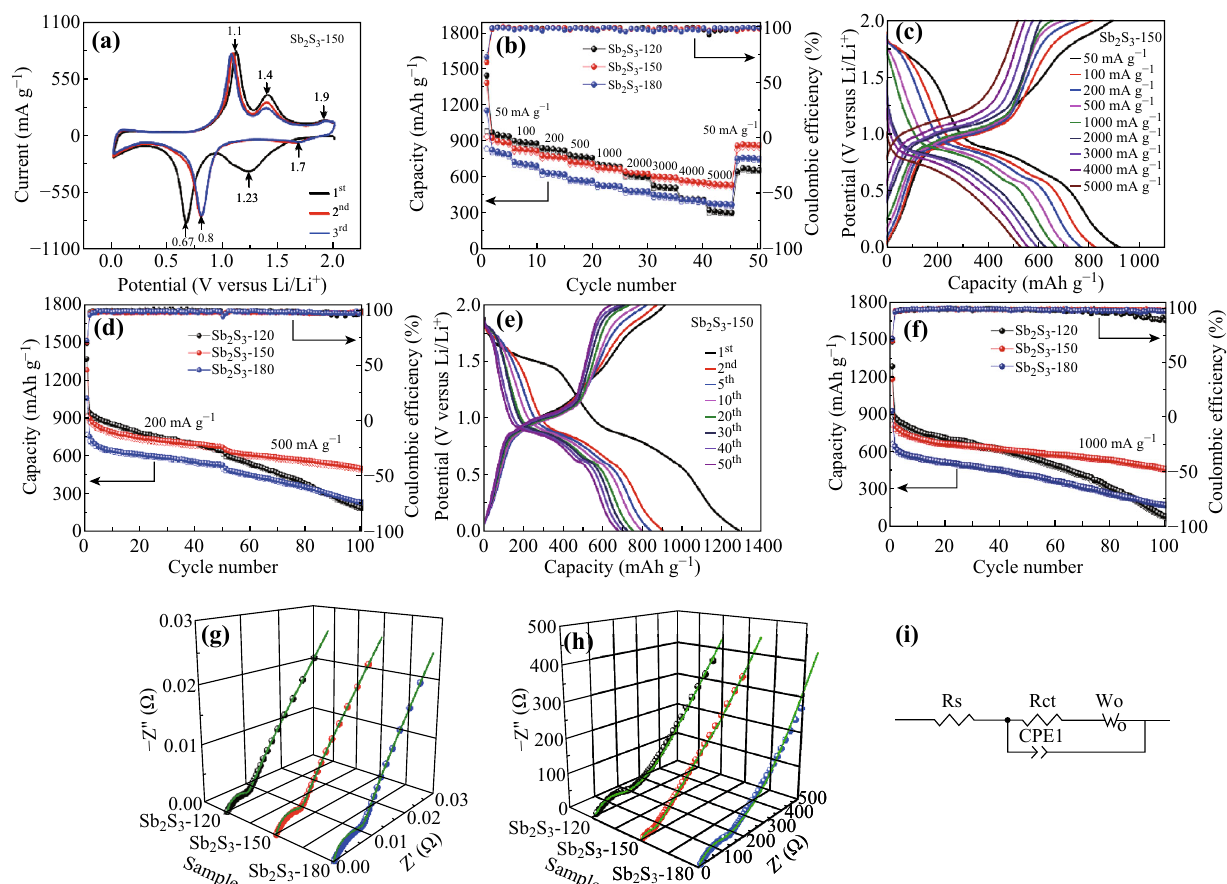
Fig. 4 Excellent lithium-storage performance of as-prepared Sb 2 S 3 electrodes. a CV curves of Sb 2 S 3 -150 electrode for the first three cycles at a scan rate of 0.1 mV s - 1 . b Rate performance of Sb 2 S 3 -120, Sb 2 S 3 -150, and Sb 2 S 3 -180 electrodes at various current densities from 50 to 5000 mA g - 1 . c Selected charge/discharge voltage profiles of Sb 2 S 3 -150 electrode at different current densities (increased from 50